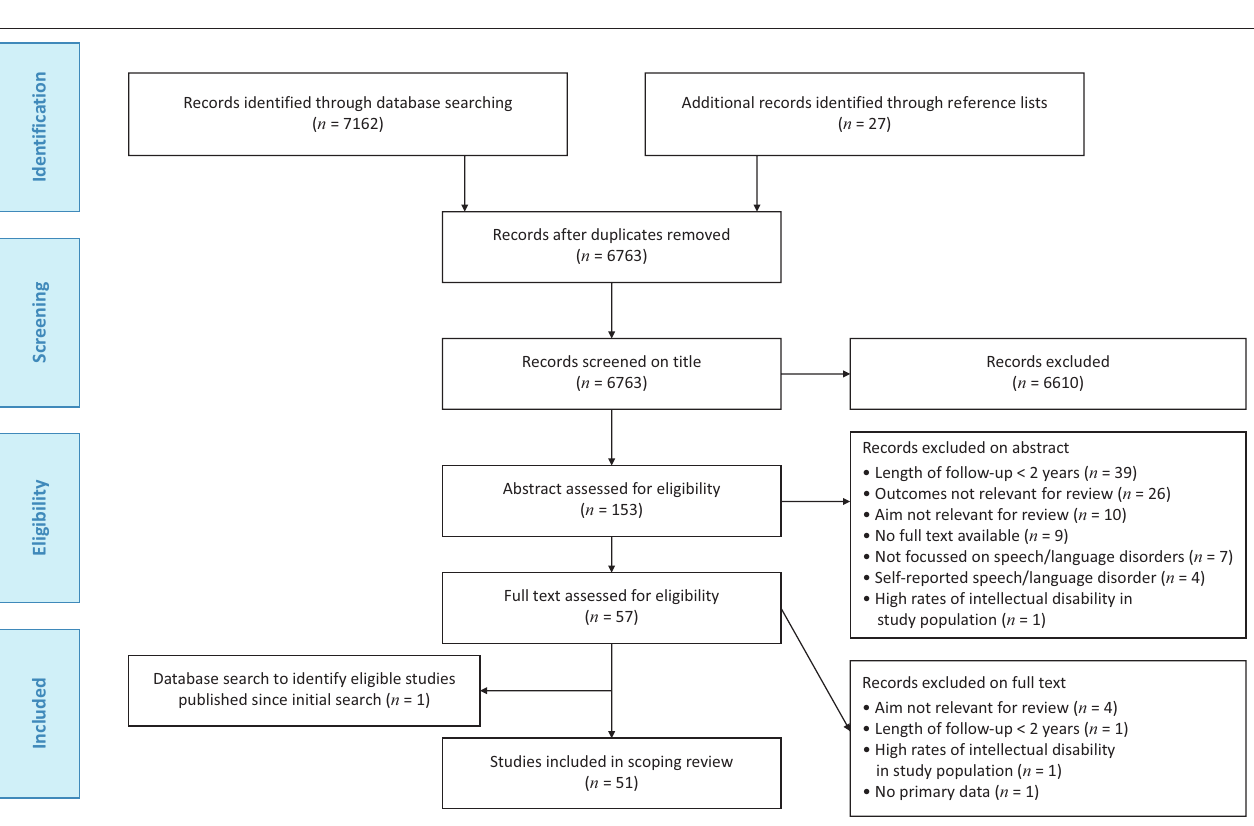
PRISMA, Preferred Reporting Items for Systematic Reviews and Meta-Analyses. FIGURE 2: PRISMA flow chart showing study